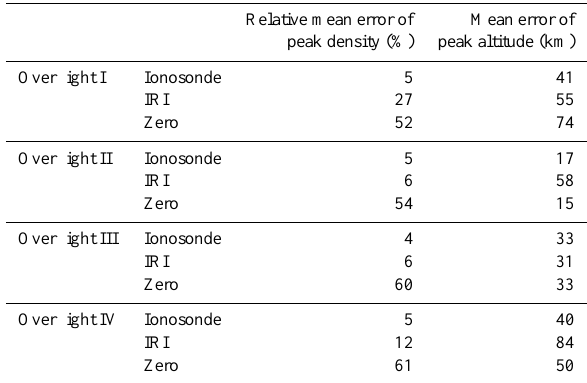
Table 1. Errors of tomographic profiles compared with EISCAT UHF